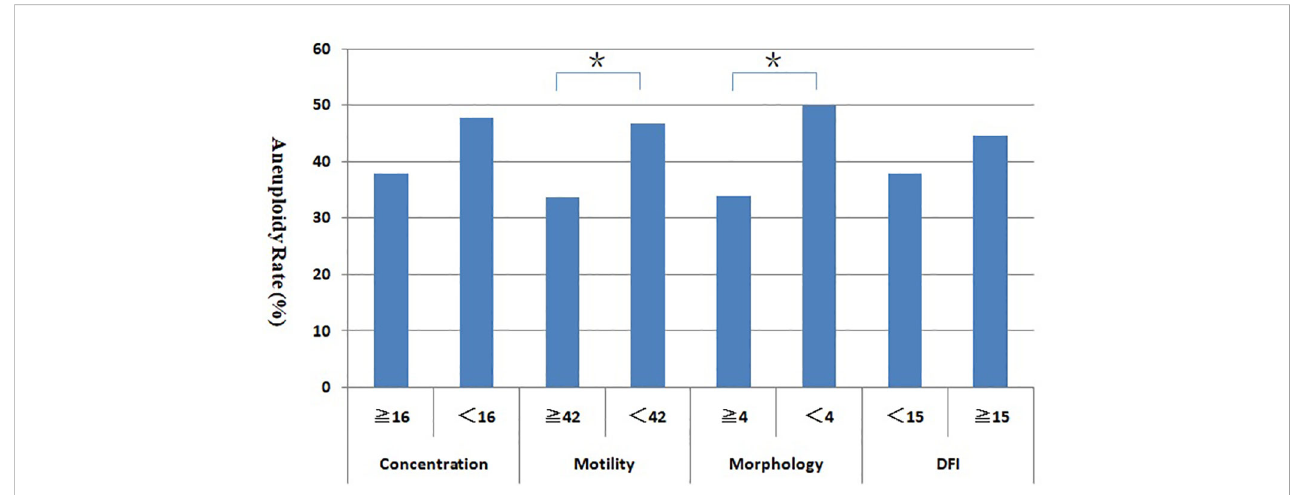
FIGURE 3 Relationship between sperm parameters and blastocyst aneuploidy rate. *Statistically signi fi cant (P < 0.05).